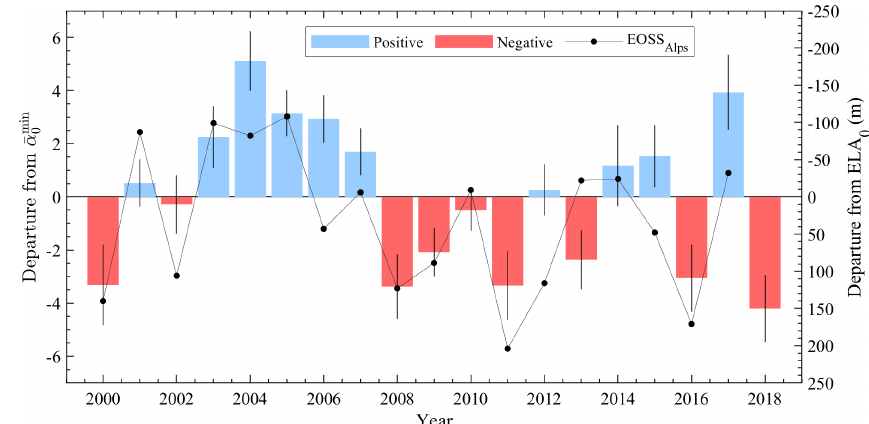
Figure 7. Annual departure and standard error of the mean ¯ α min yr across the 12 outlet glaciers from the long-term average ¯ α min yr ( ¯ α min between 2000 and 2018. The average annual departure of the EOSS index glaciers from their respective ELA 0 (EOSS Alps ) is also included. Linear agreement between the records is R 2 = 0 .